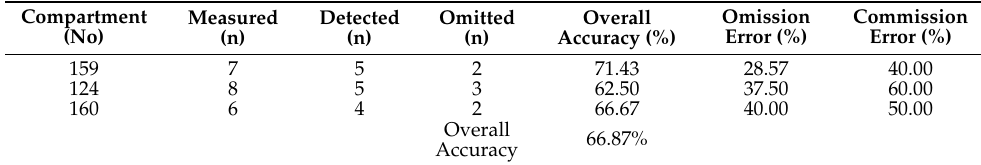
Table 4. Error matrix for stump detection by using OBIA.